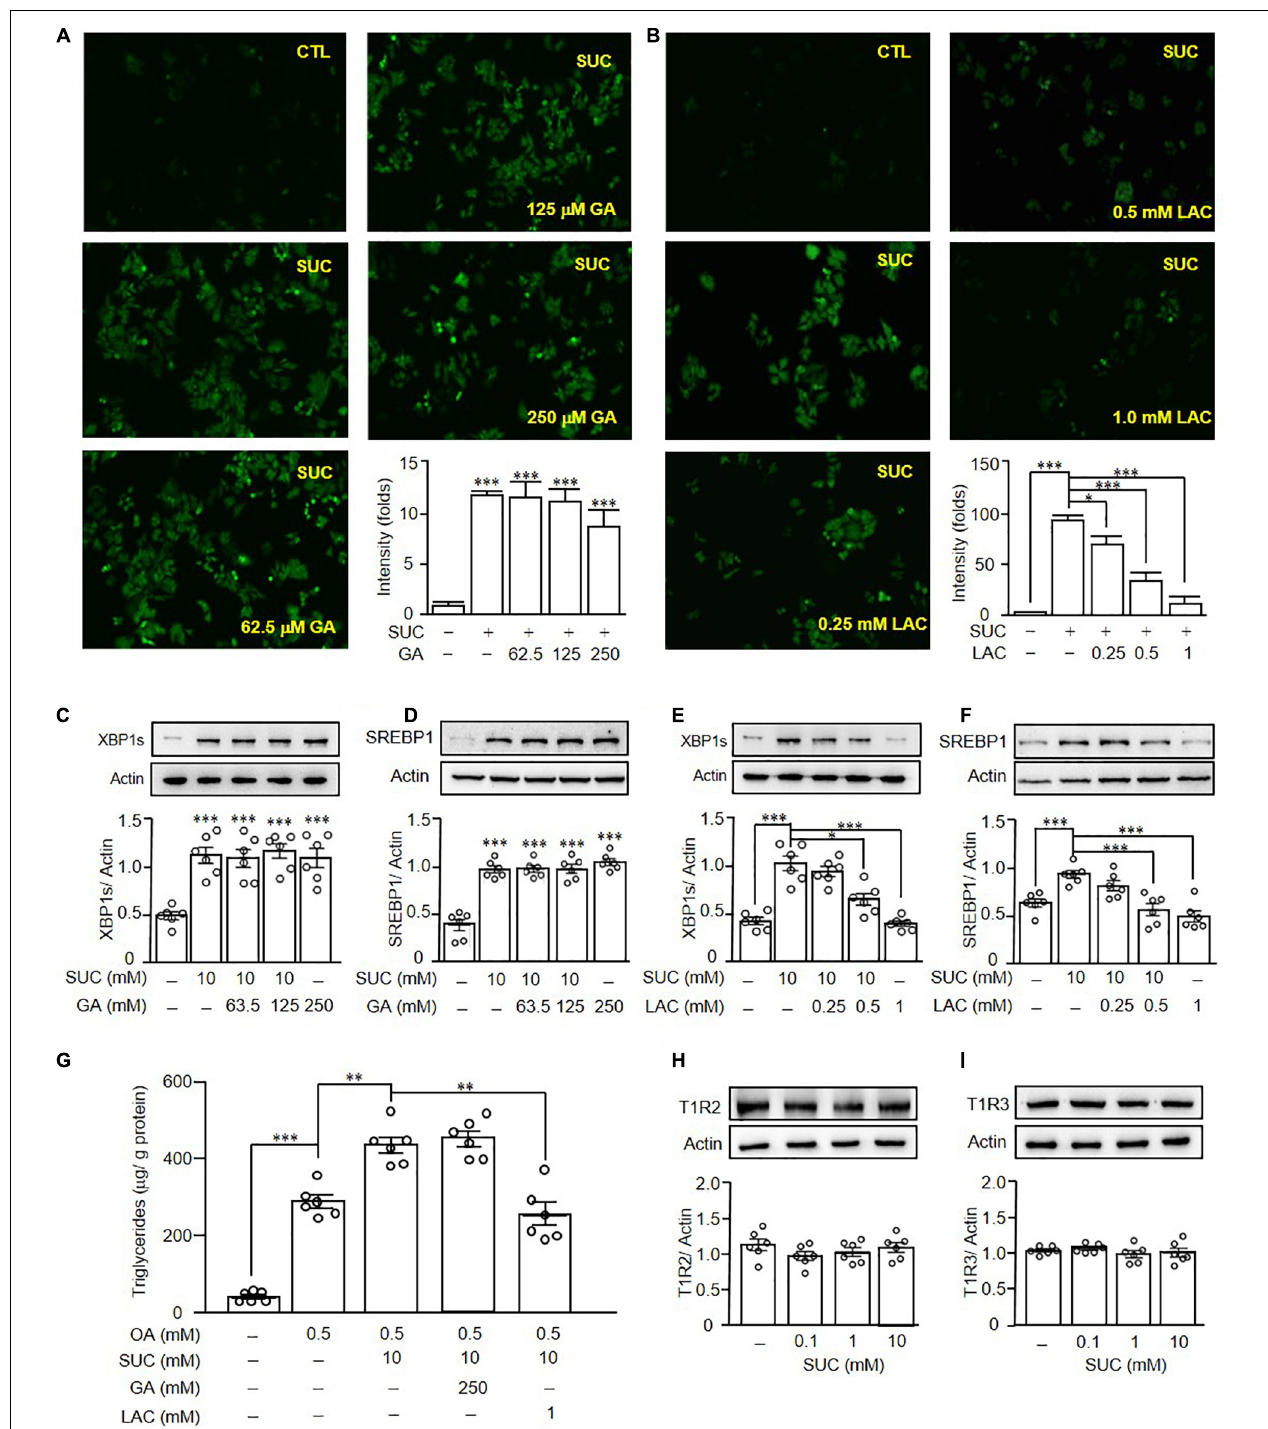
FIGURE 6 | Sucralose induced reactive oxygen species generation and lipogenesis through T1R3. HepG2 cells were pretreated with gymnemic acid (GA) (A) or lactisole (LAC) (B) at indicated doses for 30 min, and then treated with 10 mM sucralose (SUC) for another 90 min. The reactive oxygen species production was determined by DCFDA staining, and the fluorescence intensity was analyzed by ImageJ software (original magnification 100X). HepG2 cells were pretreated with GA (C,D) or LAC (E,F) at indicated doses for 30 min, and then treated with 10 mM sucralose for another 24 h to determine XBP1s, and SREBP1 expressions by Western blots. In addition, the cells were harvested to determine the intracellular triglyceride contents using a commercialized assay kit (G) . The cells were treated with 10 mM sucralose for 24 h to determine T1R2 (H) and T1R3 (I) expressions by Western blots. Data are mean ± SEM ( n = 6 for each group) ∗ p < 0.05, ∗∗ p < 0.01, ∗∗∗ p < 0.001 as compared with indicated